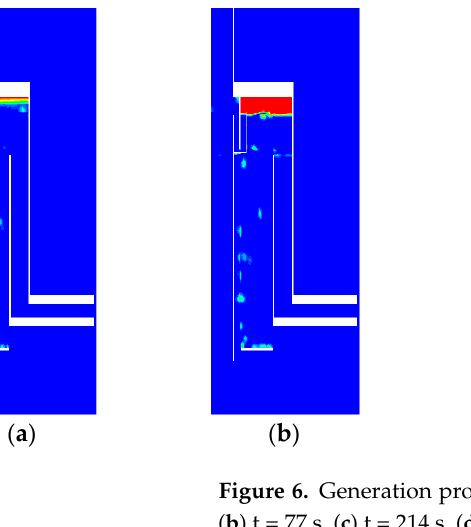
9 of 20 Figure 5. Comparison of computational and experimental results of the velocity in the ascending tube. 3.2. Analysis of the Internal Flow of the Water-Lifting Aerator